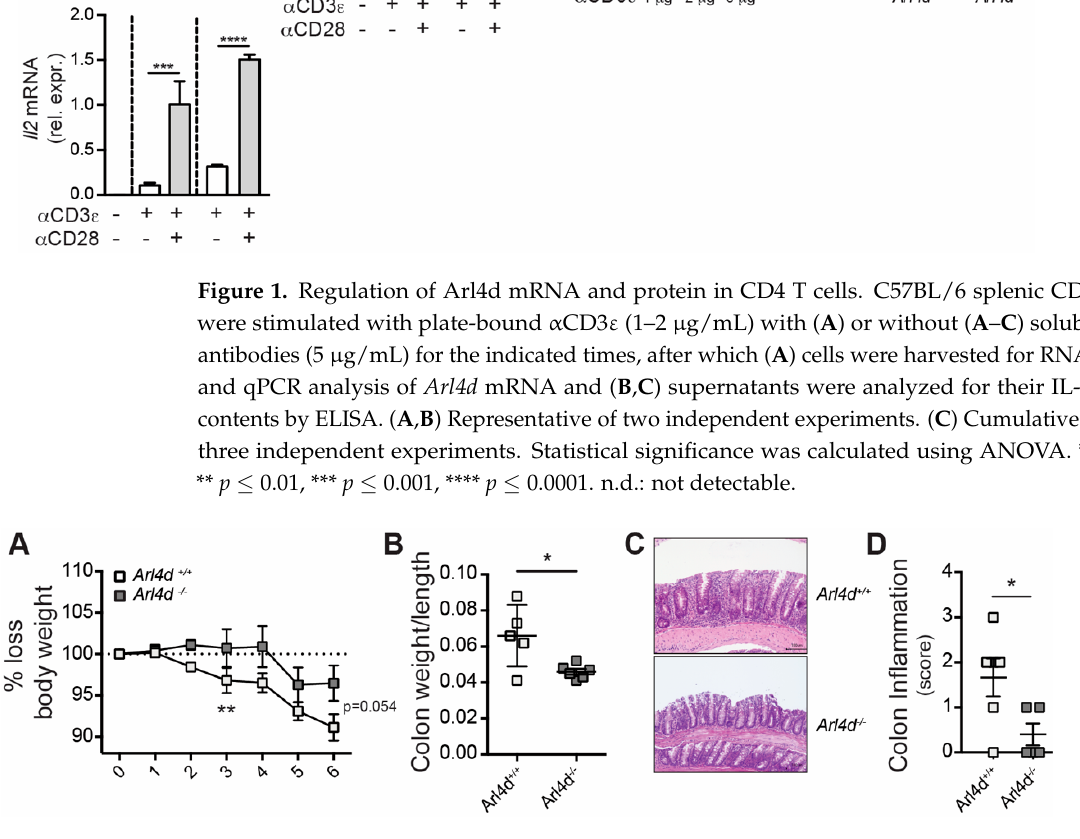
Arl4d − / − CD4 T cells, indicating that the expression of Arl4d in CD4 T cells augments colitis severity. Figure 1. Regulation of Arl4d mRNA and protein in CD4 T cells. C57BL/6 splenic CD4 + T cells were stimulated with plate-bound α CD3 ε (1–2 μ g/mL) with ( A ) or without ( A – C ) soluble α CD28 anti- bodies (5 μ g/mL) for the indicated times, after which ( A ) cells were harvested for RNA isolation and qPCR analysis of Arl4d mRNA and ( B , C ) supernatants were analyzed for their IL-2 or IFN γ contents by ELISA. ( A , B ) Representative of two independent experiments. ( C ) Cumulative data from three independent experiments. Statistical significance was calculated using ANOVA. * p ≤ 0.05, ** p ≤ 0.01, *** p ≤ 0.001, **** p ≤ 0.0001. n.d.: not detectable.